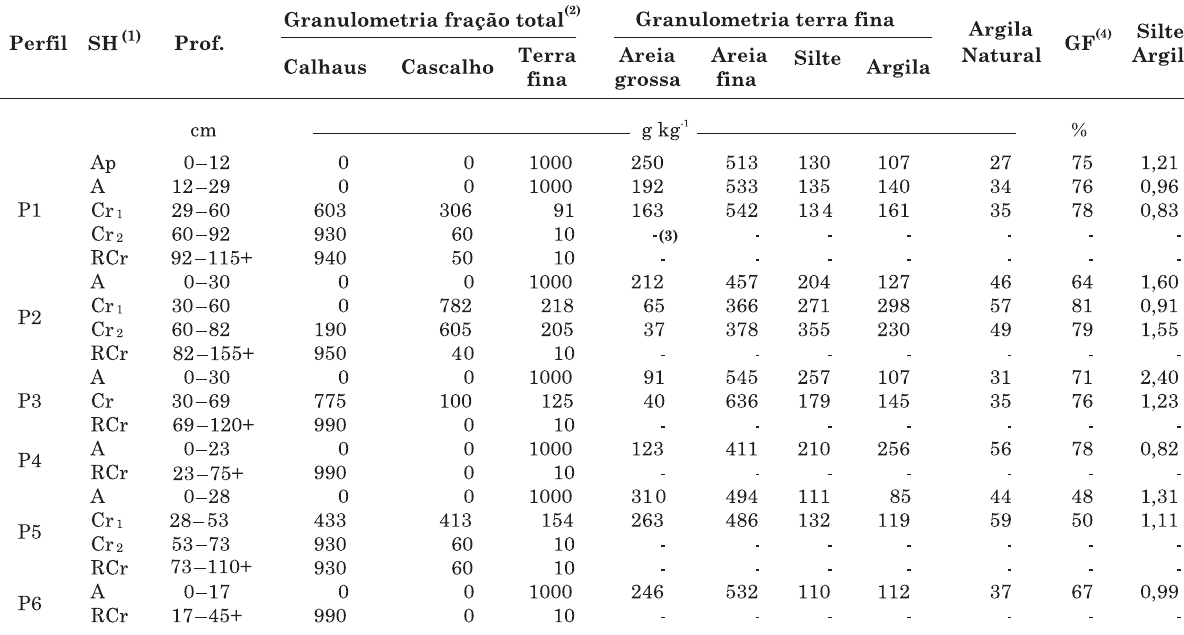
) dos perfis dos s